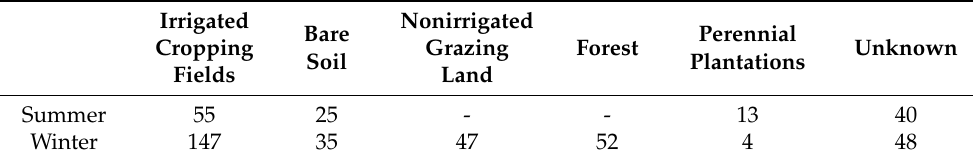
Figure 7. Training samples for winter and summer classification. Each point represents a field. The nonirrigated grazing samples were collected at the surrounding area of the CIA. Table 2. The number of training samples in each class.